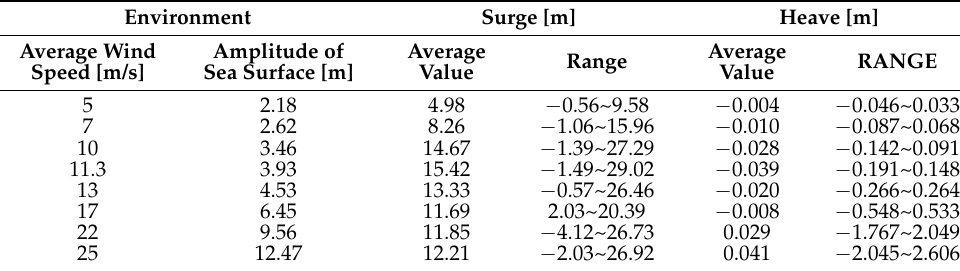
Table 5. FAST simulation results of the surge and heave according to the marine environment. Environment